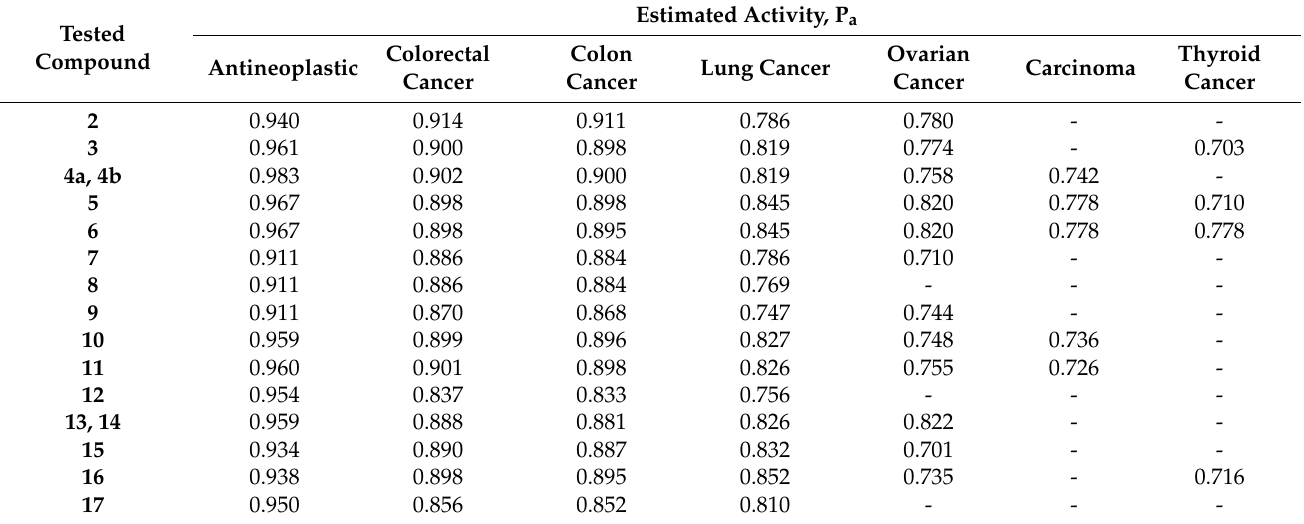
Table 1. PASS-predicted biological activities of the compounds 2 – 17 .